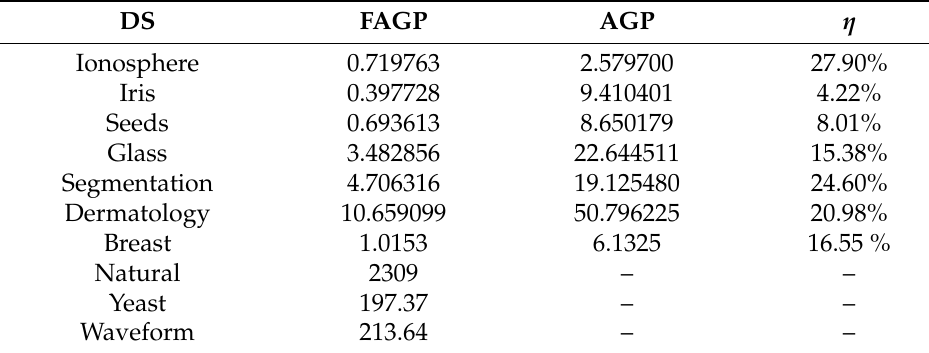
Table 6. Running time (s) comparison of FAGP and AGP.